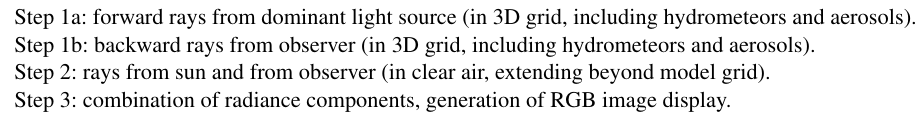
Table 1. Overview of functionality in a sampling of radiative transfer packages. SWIm CRTM RRTMG SHDOM Monte Carlo 3D radiation (including Yes No No Yes Yes sideways) between columns Multiple scattering Approximate Yes Yes Yes Yes Fast running Yes Yes Yes No No Ground-, air-, or space-based observer All Space Space Curved earth shadow/twilight Yes Moon/stars/city lights Yes 2D (directional) images Wavelengths Visible Grid resolutions Table 2. List of ray tracing steps used in SWIm. Steps 1a and 1b are illustrated in Fig. 1. Step 1a: forward rays from dominant light source (in 3D grid, including hydrometeors and